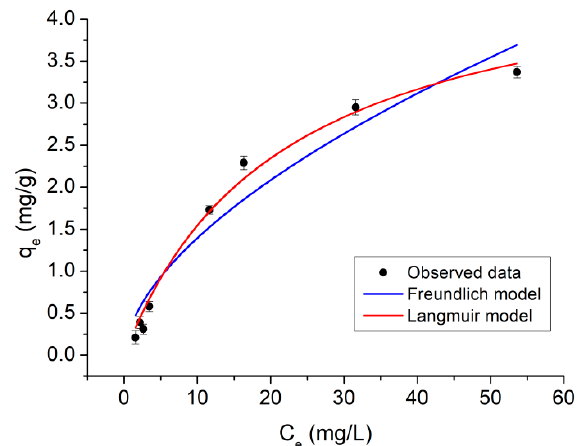
Figure 7. Bisphenol A adsorption isotherm at 20 °C onto biobased FF (black symbols) and fitting with the Langmuir (red line) and Freundlich (blue line) models.